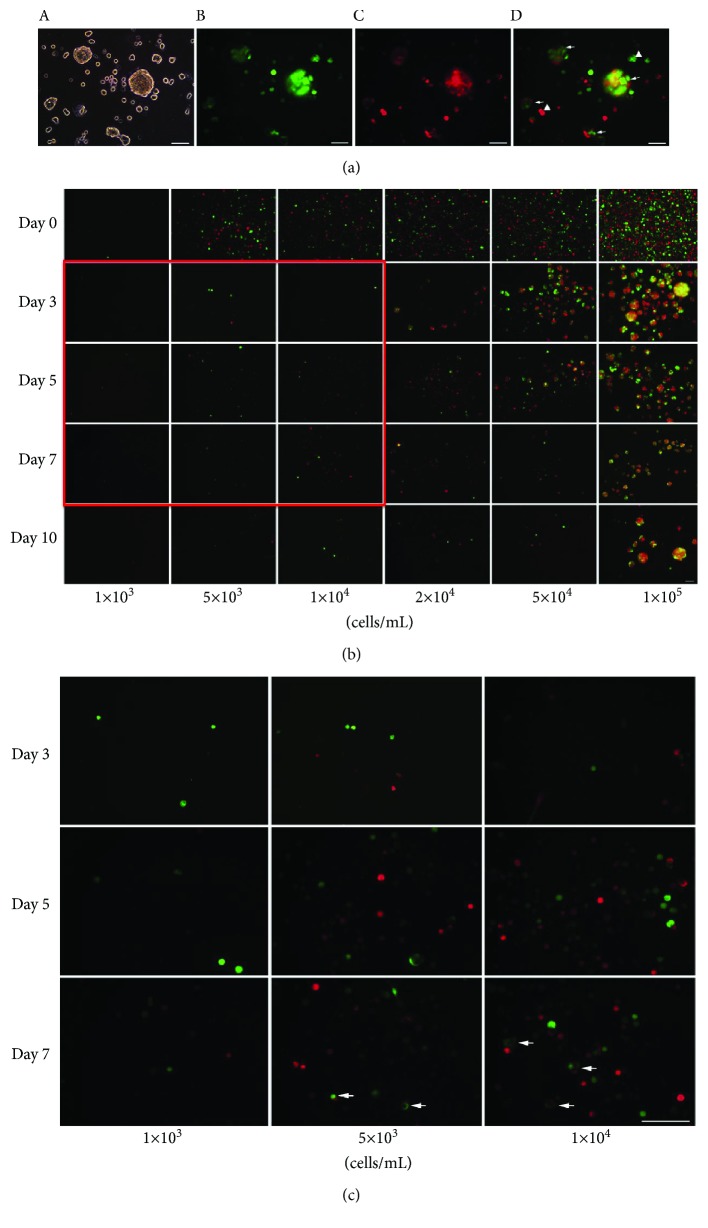
tSKP spheres generated from FBs contain aggregated cells. (a) tSKPs generated from mixed FBs expressing either EGFP or mCherry equally with a seeding density of 2‐4 × 104 cells/mL. Phase contrast (A) and fluorescence photomicrograph (D) of tSKPs five days after transculture. Immunofluorescence detection of EGFP- (green) (B) and mCherry-positive cells (red) (C) in tSKP spheres, respectively. Arrows indicated spheres containing both EGFP- and mCherry-positive cells, and arrowheads showed spheres consisted of cells expressing either EGFP or mCherry alone. (b) Formation of tSKP spheres derived from mixed-FB plating at different densities of 1 × 103, 5 × 103, 1 × 104, 2 × 104, 5 × 104, and 1 × 105 cells/mL. (c) Enlarge the red box of (b). Arrows showed the spheres formed at a density of 5 × 103 and 1 × 104 cells/mL consisted of both EGFP- and mCherry-positive cells in day 7. Scale bars: 100 μm.